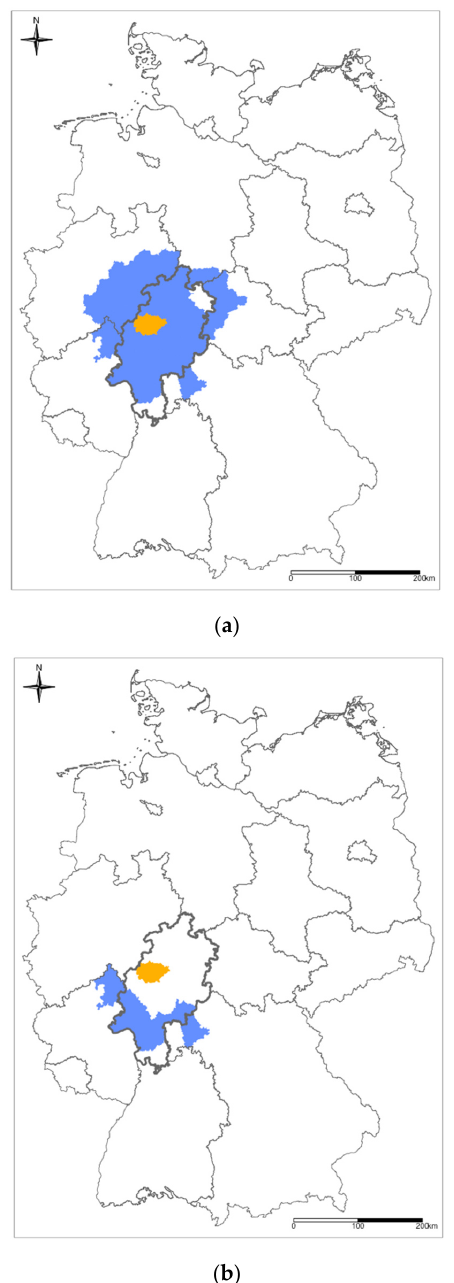
Figure 1. ( a ) Map of the Federal Republic of Germany. University Hospital Marburg is located in the district of Marburg–Biedenkopf (orange), which is part of the German federal state of Hesse (bold black). The contiguous part of the hospital’s catchment area for neurotrauma patients admitted between 1 January 2018 and 31 December 2021 (blue) extends into the neighboring federal states of (clockwise, beginning in the north) Lower Saxony, Thuringia, Bavaria, Rhineland–Palatinate, and North Rhine–Westphalia. ( b ) The southwestern margin (SWM; blue) of the hospital’s contiguous neurotrauma catchment area extends to the densely populated Frankfurt Rhine—Main metropolitan region, part of which belongs to the German federal state of Hesse (bold